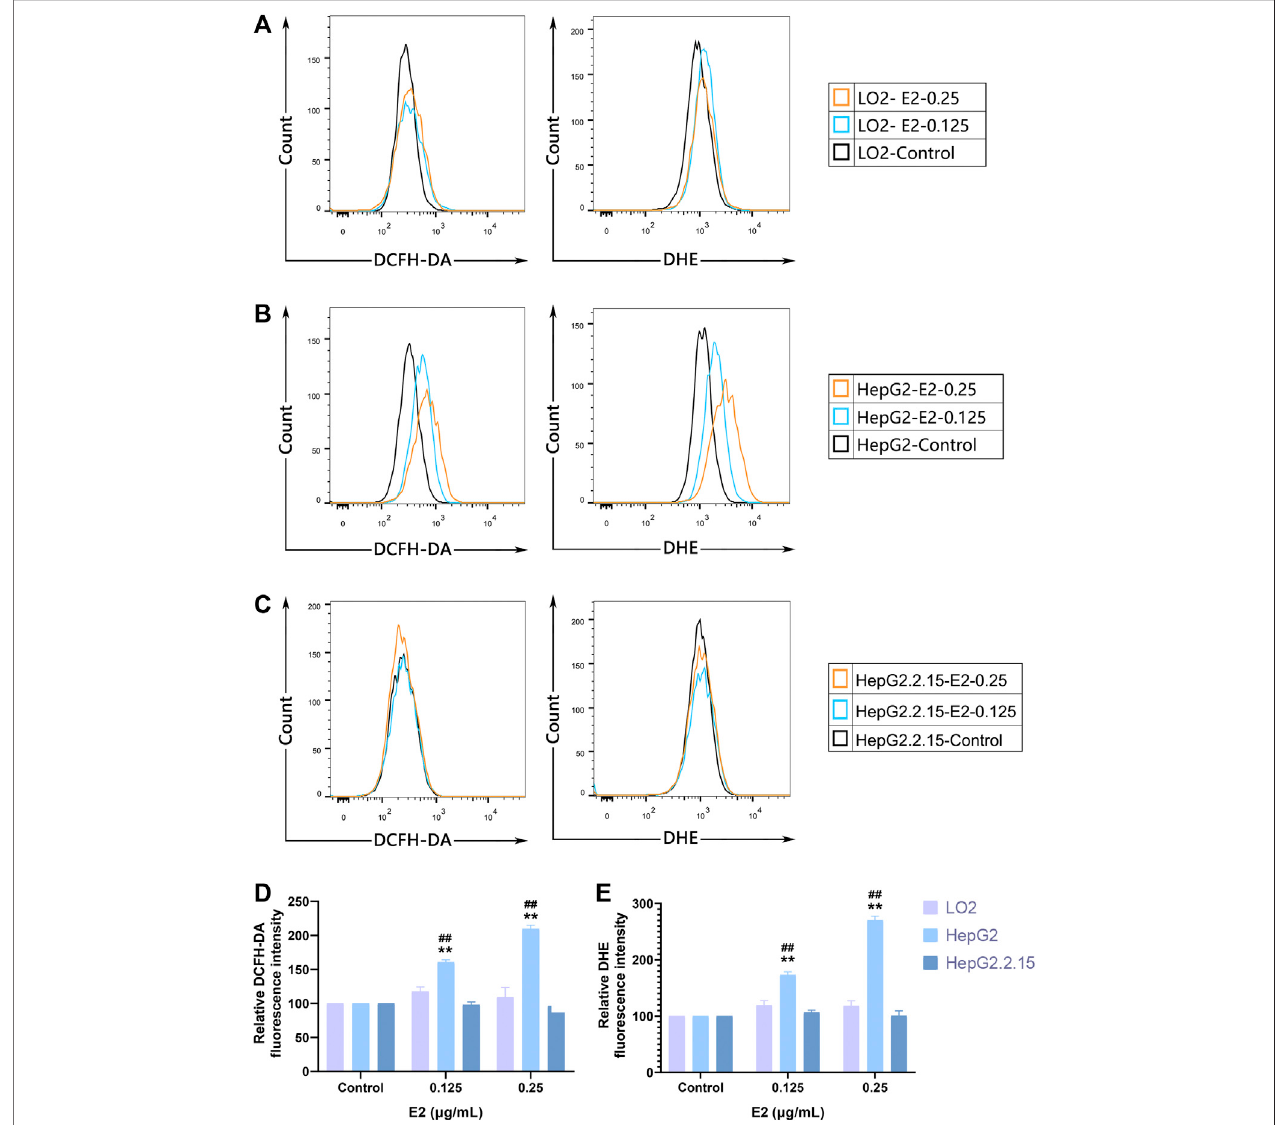
FIGURE3| ROSaccumulationincellsasassessedby fl owcytometry. (A – C) FluorescentROSpeaksofHepG2,HepG2.2.15,andLO2cells,respectively,induced by17 β -estradiol.Aftertreatmentwith17 β -estradiolfor48 h,cellswerestainedusingDCFH-DAandDHE fl uorescentprobesandexaminedby fl owcytometry. (D,E) The histogramsshowthedifferencesintheROSlevelsofHepG2andLO2cells.Allexperimentswereperformedintriplicate,** p < 0.01comparedtothecontrolgroup,## p < 0.01 compared to LO2 cells at the same dose.